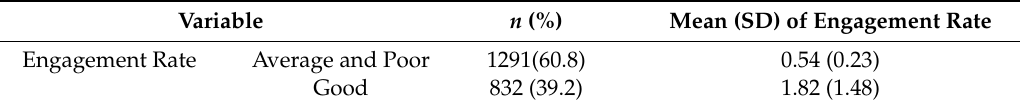
Table 2. Engagement rates of posts on MOH FB page ( n =